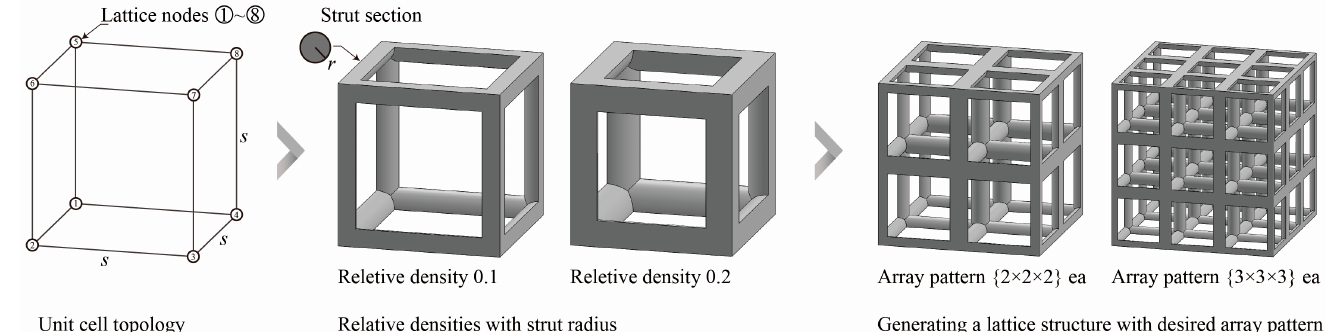
Figure 2. Scheme of the conventional simple cubic lattice structure configuration method.